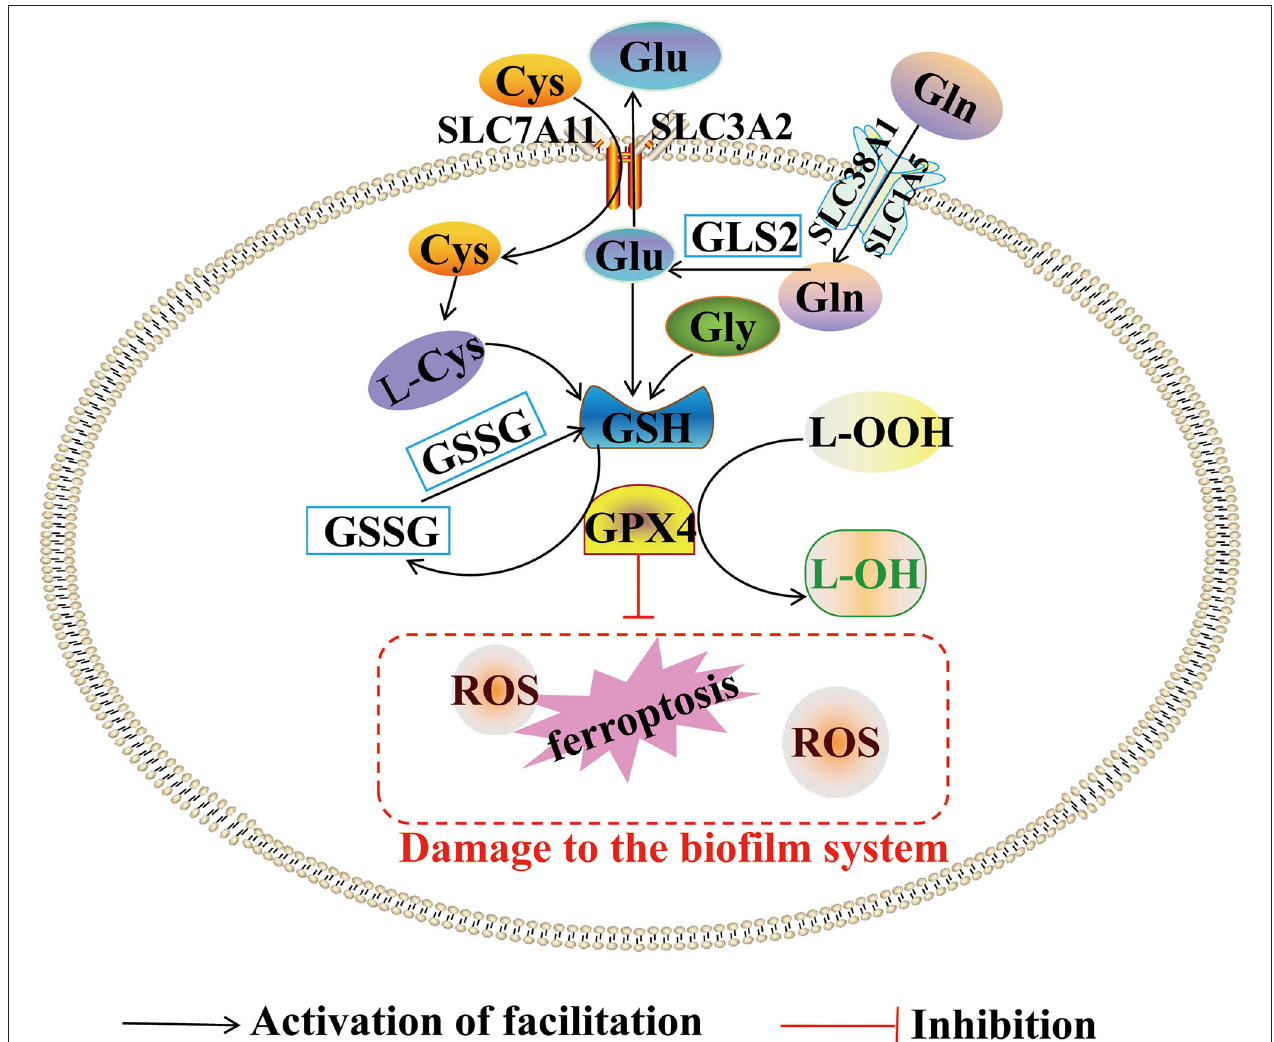
FIGURE 3 | Abnormal metabolism of amino acids and ferroptosis. This figure summarizes the regulatory effect of amino acids metabolism on ferroptosis. The black arrow represents the activating role of lipid metabolism. The red inhibition arrow represents the inhibiting role of lipid metabolism.